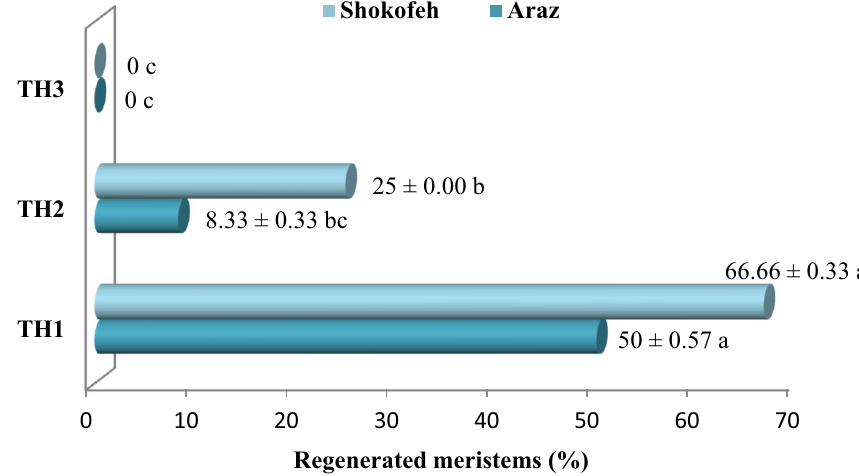
Figure 2. Interaction effects of 2 cultivars × 3 thermotherapy treatments on the percentage of regenerated meristems; TH1: 18 days at 27 °C for 8 h and 38 °C for 16 h, TH2: 10 days at 38 °C and TH3: 11 days at 38 °C. (n = 3, p < 0.05, ± S.E).